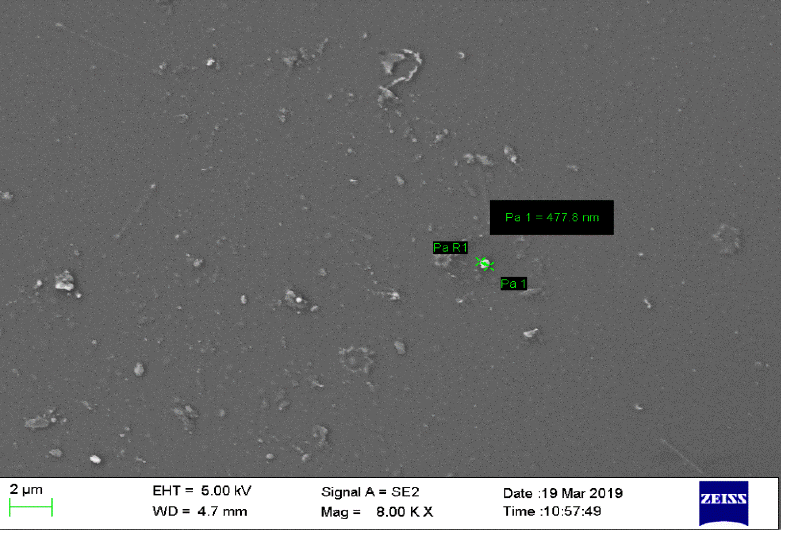
Figure 3. Scanning Electron Microscopy image of chitosan nanoparticles showing regular shape.